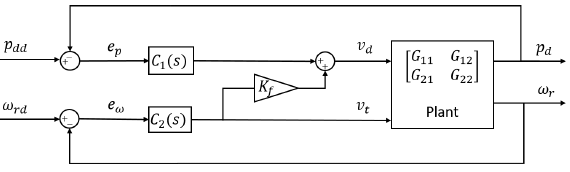
Figure 12. Schematic start and stop phase control architecture.